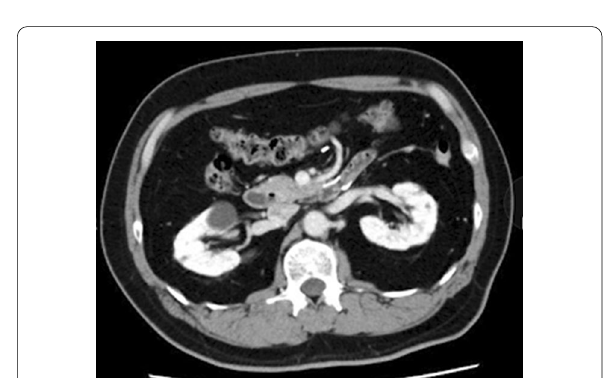
Fig. 6 Contrast-enhanced computed tomography findings 2 years after surgery. Neither signs of recurrence nor stenosis has been